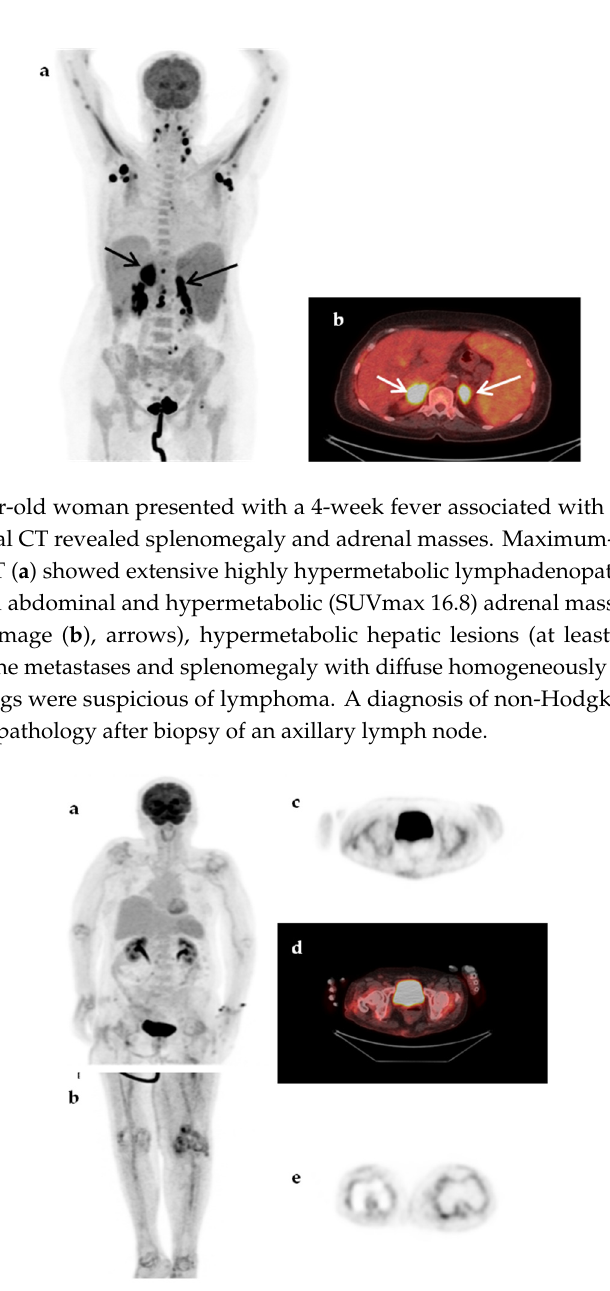
Table 6. Clinical and laboratory characteristics of patients with contributory and non-contributory scans. Characteristic